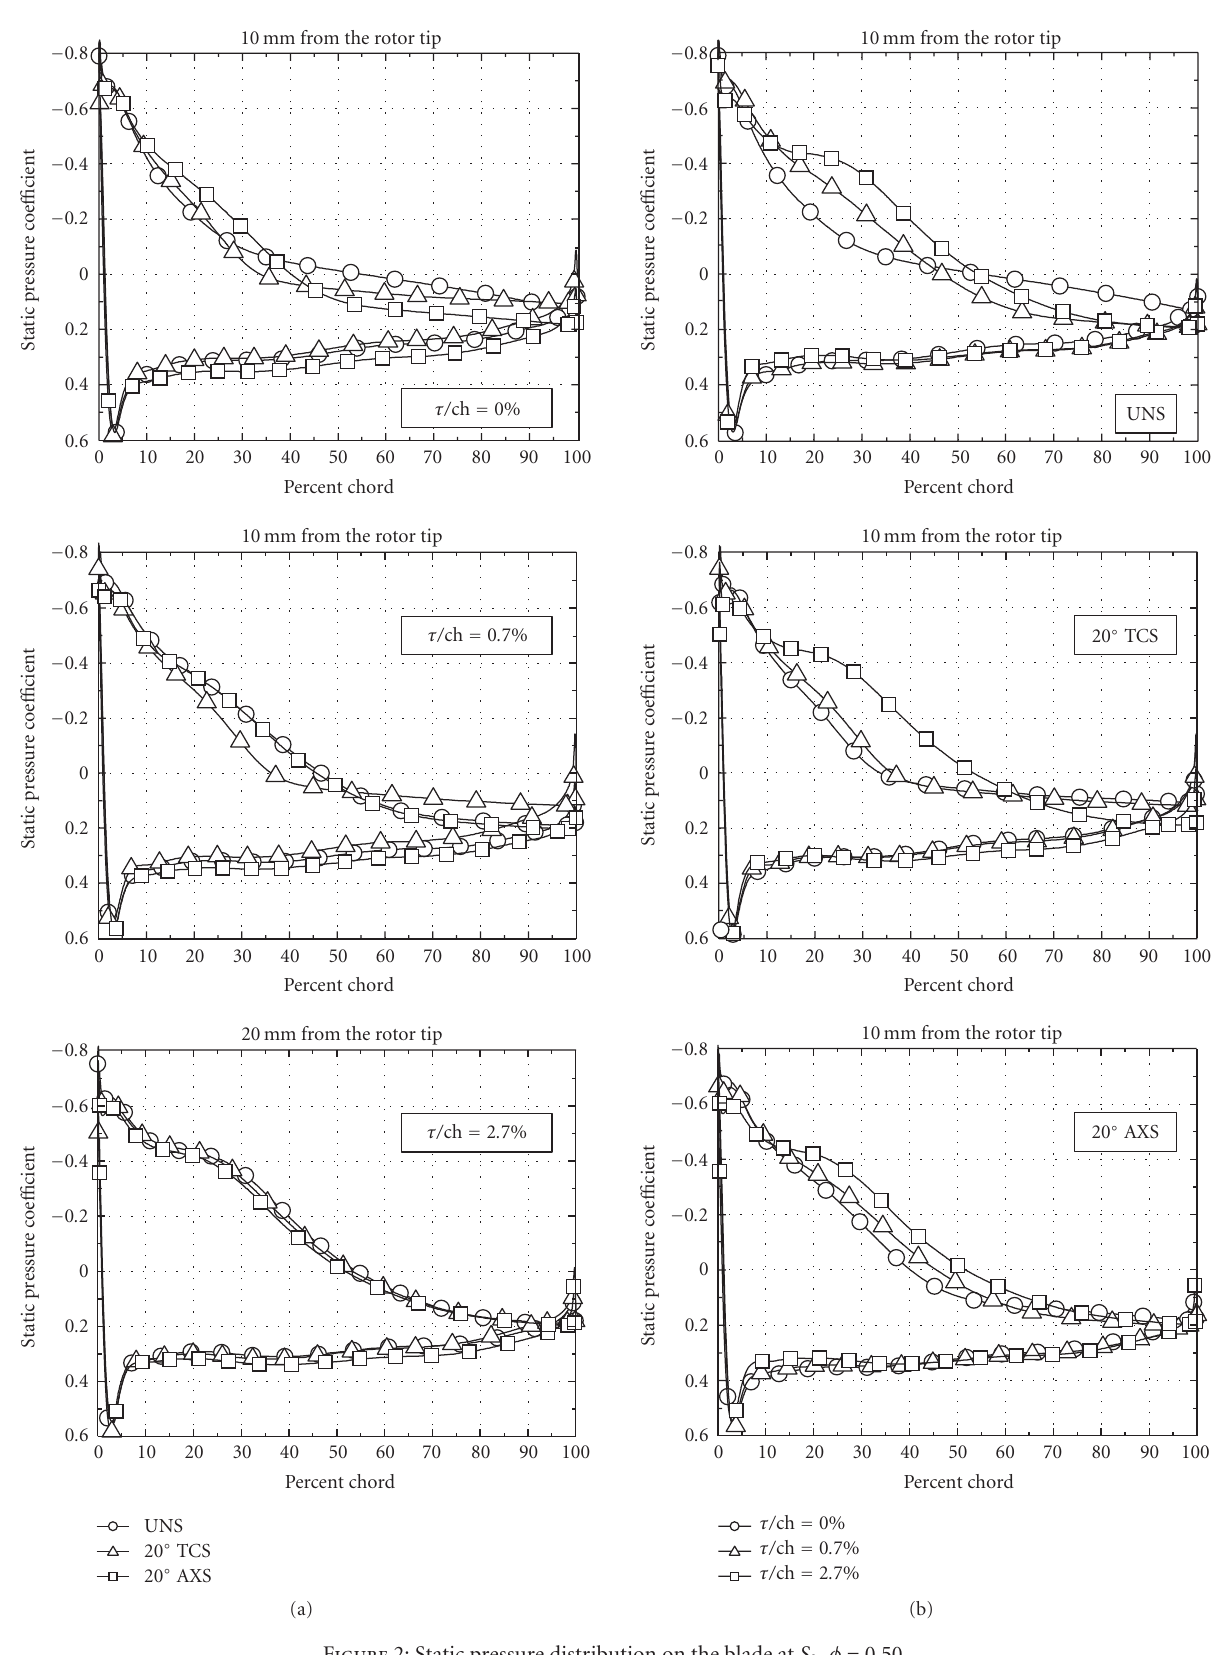
Figure 2: Static pressure distribution on the blade at S 2 , φ =